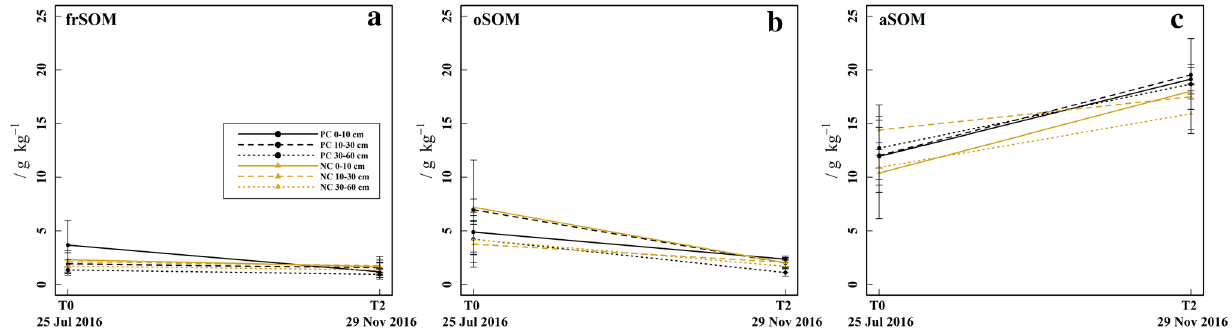
coverage (NC), respectively, shown as mean with standard devia- tion (n = 5). b Aggregate occluded soil organic matter (oSOM).